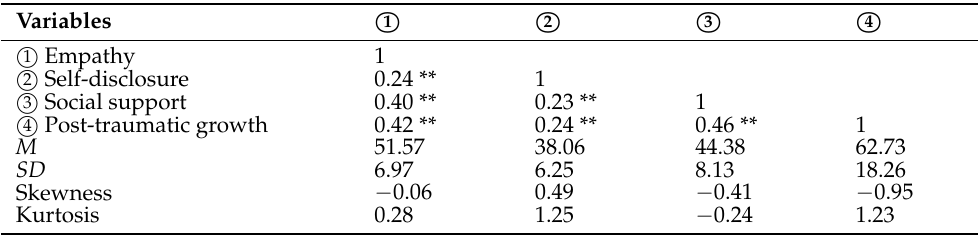
Table 2. Correlational matrix of empathy, self-disclosure, social support, and post-traumatic growth ( N =